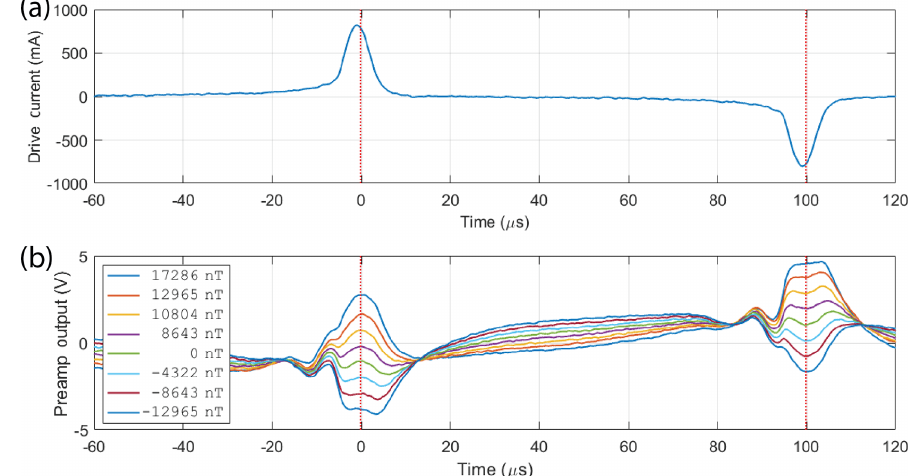
Figure 18. (a) The current wave from the tuned drive circuit ensures that the ring cores are in deep magnetic saturation. (b) Time series of the sense-coil output after the preamplifier, showing the response to different magnetic field intensities.